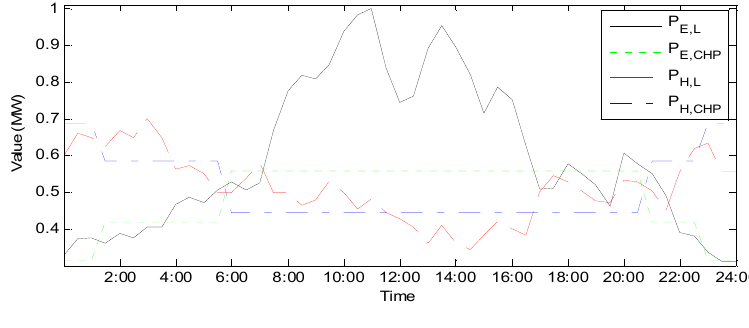
Figure 8. Load demand and output of CHP.